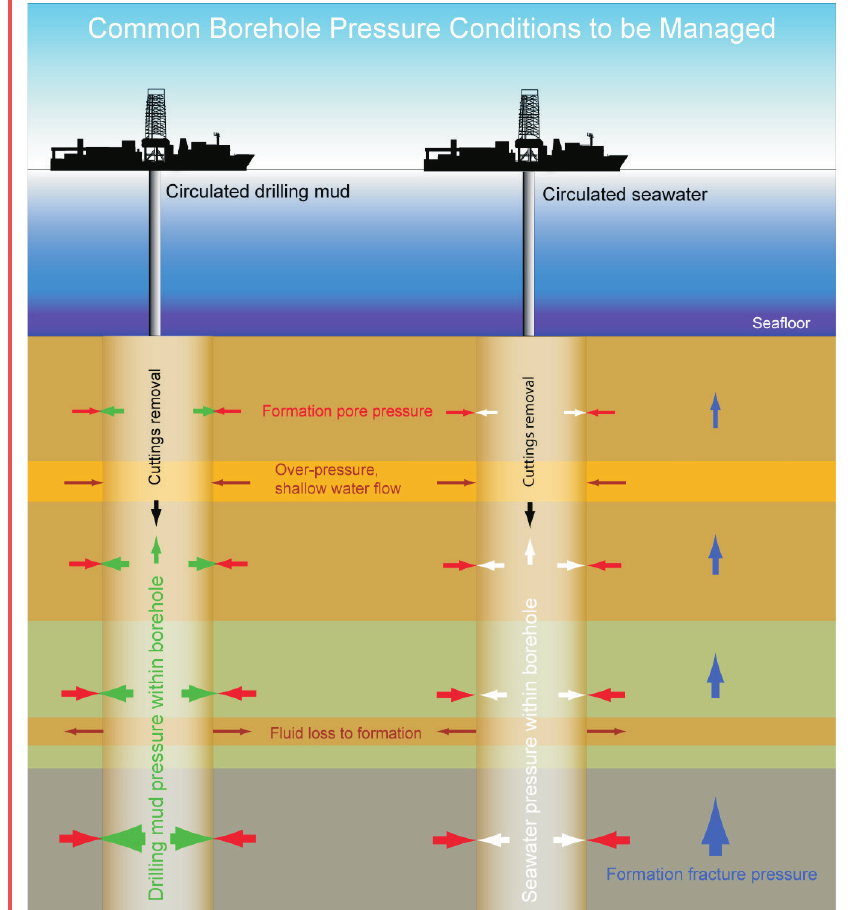
Figure 2. The pressure conditions within an offshore borehole are complex and must be precisely managed to achieve the target depth. Carefully selected drilling fluids provide the pressure needed to resist the formation pore pressure thereby keeping the borehole open without applying too much pressure and fracturing the formation. This optimal pressure zone between formation pore pressure and formation fracture pressure is known as the drilling “window”. When drilling with seawater, the formation pore pressure overcomes the borehole fluid pressure leading to borehole